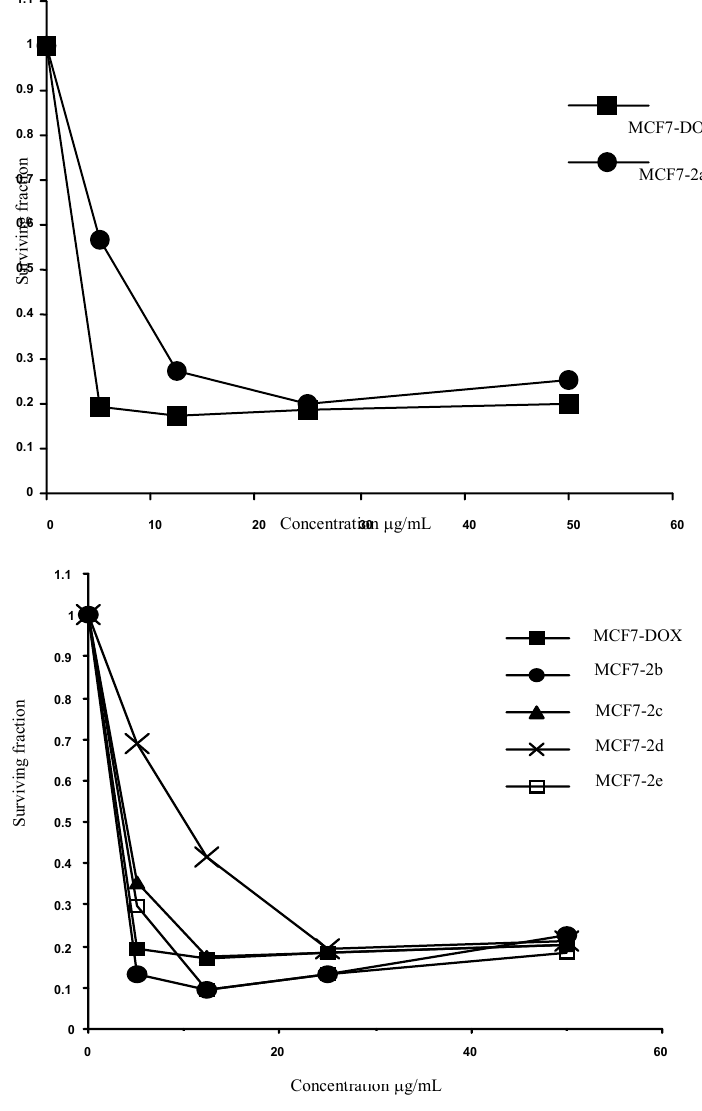
Figure (1): Drug cytotoxicity of product 2a, 2b, 2c, 2d and 2e compared to